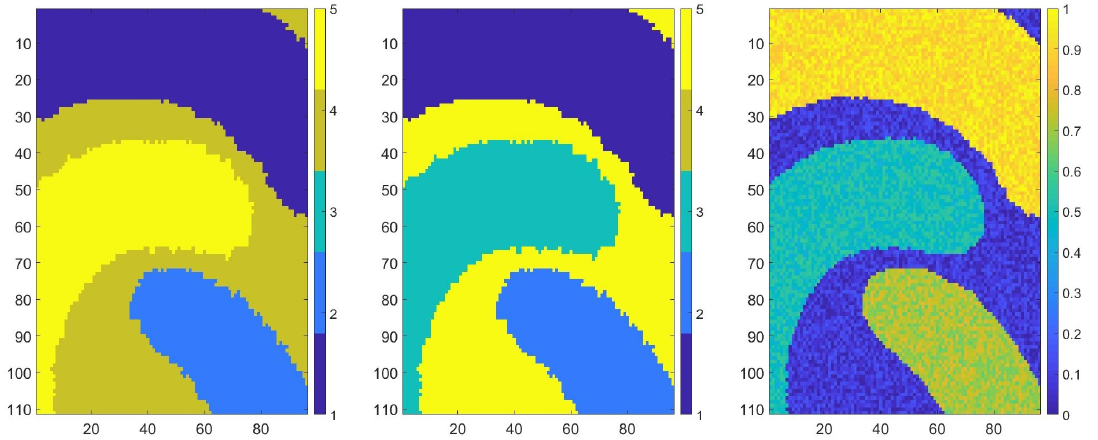
Figure 5. The Voronoi diagram of our dataset classified using seven unsupervised classifiers ( left ) and nine unsupervised classifiers ( center ); the dataset ( right